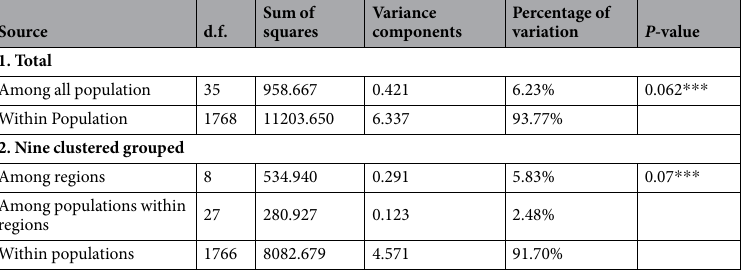
Table 2. Analyses of molecular variance (AMOVAs) for the 36 P. ostii populations. Note: d.f. = degree of freedom; *** P < 0.001.